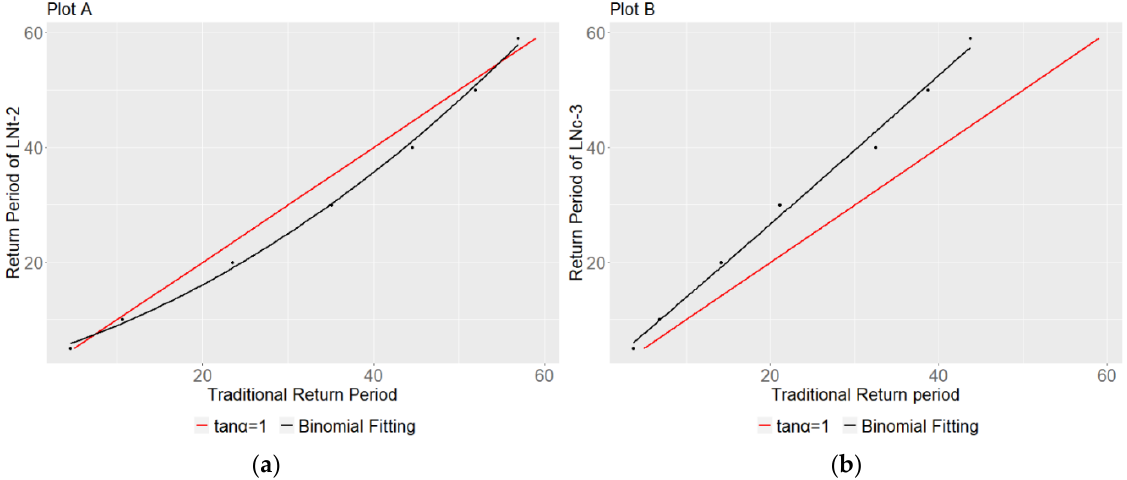
Figure 9. The return periods comparison between stationary model LN S and time-based model LNt-2 ( a ) and climate-based model LN C -3 ( b ).